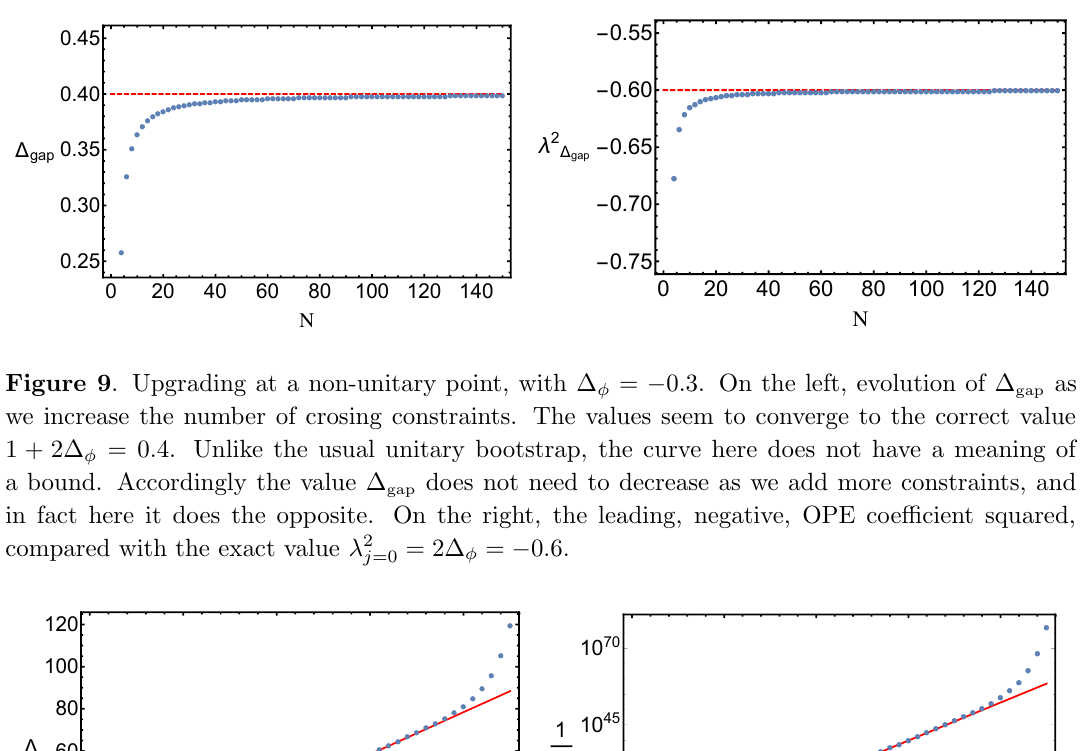
Figure 10 . Upgrading at a non-unitary point: comparison between the extrapolated spectrum (blue dots) and the exact generalized free fermion (red line). Operators are labeled by an integer j , with (cid:1) j = 1 + 2(cid:1) (cid:30) + 2 j . The (cid:12)rst 20 operators are correct to better than a part in 10 6 . Note that on the right (cid:21) 2 < 0 for j = 1 (we are showing it’s absolute